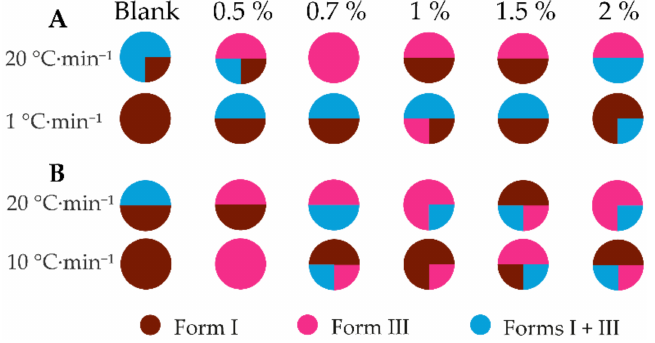
Figure 8. Polymorphic outcome of the crystallization experiments from water in the presence of different quantities of ( A ) PEG and ( B ) HPC.